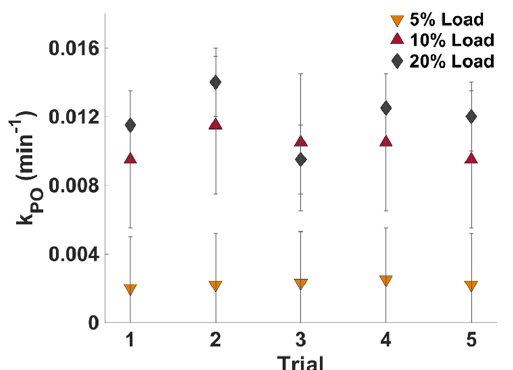
Figure 6. Reuse data for photocatalytic TiO 2 /PDMS beads, showing k TOT for three consecutive runs of 3 h each for several different loads of TiO 2 . The error bars represent the uncertainty for each value, reported in Table 3.